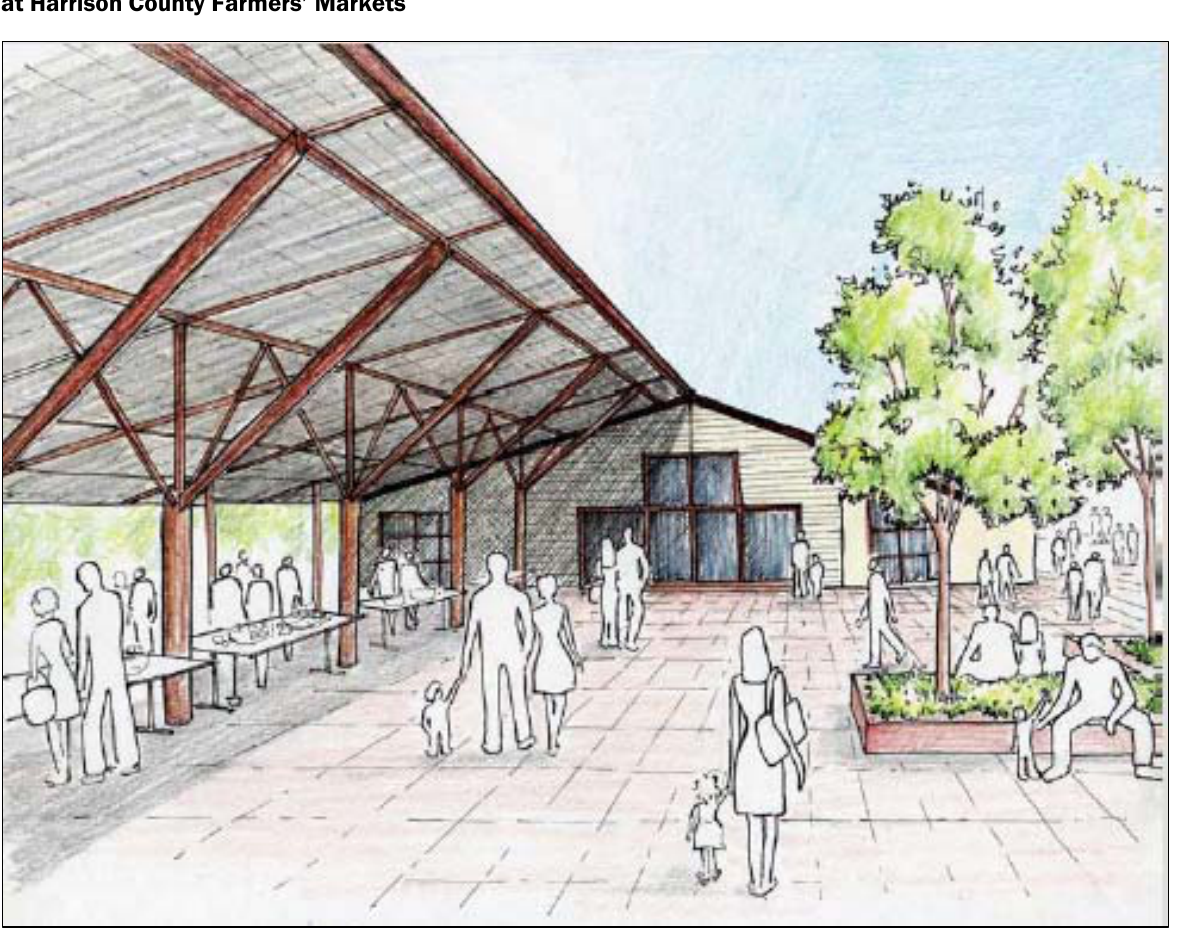
Figure 1. These Proposed Shade Structures Would Provide Protection for Farmers at Harrison County Farmers’